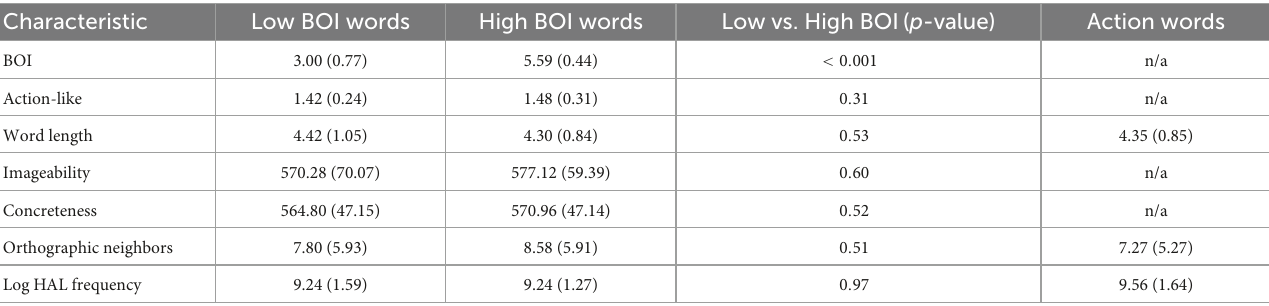
TABLE 1 Mean (SD) characteristics of low body-object interaction (BOI), high body-object interaction (BOI), and action word stimuli.